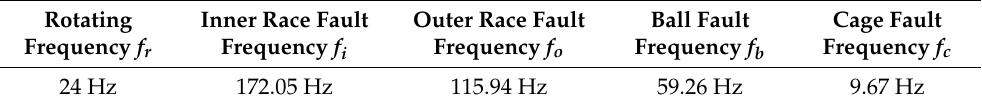
Table 2. Bearing fault characteristic frequency.